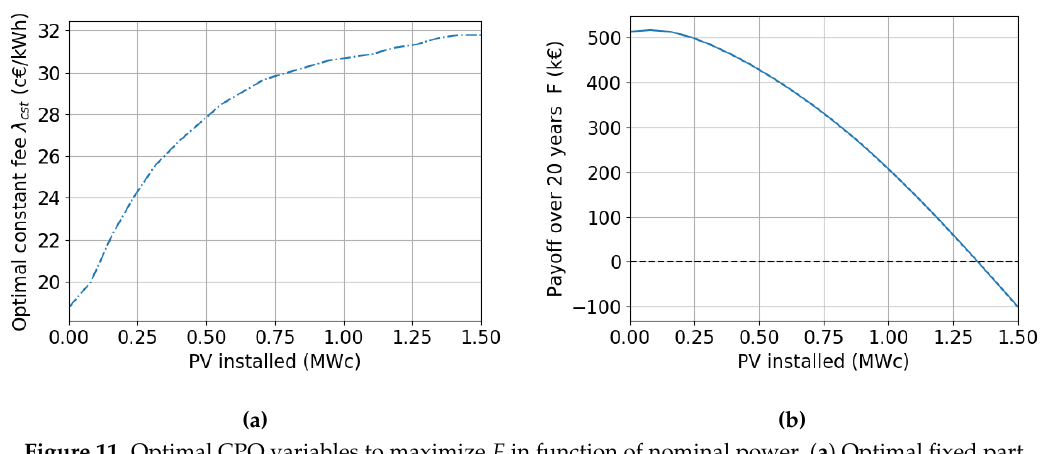
Figure 11. Optimal CPO variables to maximize F in function of nominal power. ( a ) Optimal fixed part λ ∗ cst in function of nominal power; ( b ) Payoff F (with λ cst = λ ∗ cst ) in function of nominal power. The variable charging unit price λ e offers a little more benefit than a fixed one ( λ cst , Figure